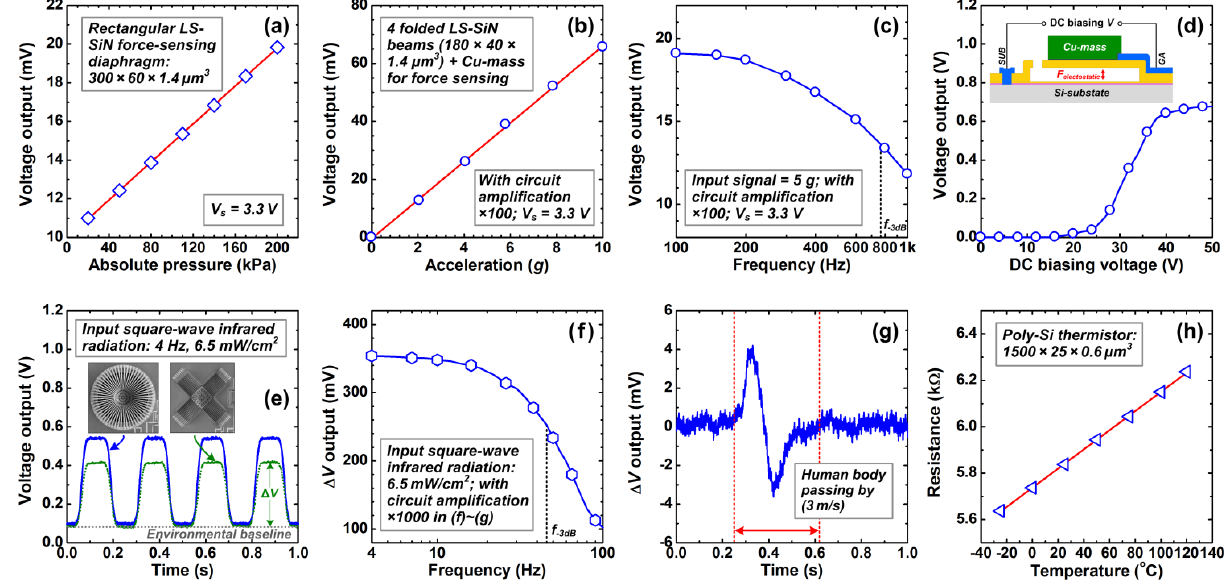
Figure 5. Measurement results of the PATIR composite sensor. ( a ) Output response of the absolute-pressure sensor under pressure inputs. ( b ) Output response of the accelerometer under acceleration loads. ( c ) Frequency response of the accelerometer. ( d ) Self-test response of the accelerometer. The inset illustrates the principle of the developed self-test technique. ( e ) Real-time responses of the circular-membrane and square-membrane infrared detectors under the blackbody radiation signal. ( f ) Frequency response of the circular-membrane infrared detector. ( g ) Real-time response of the circular-membrane infrared detector when a human body passing by with 2 m distance. ( h ) Output response of the thermistor under temperature